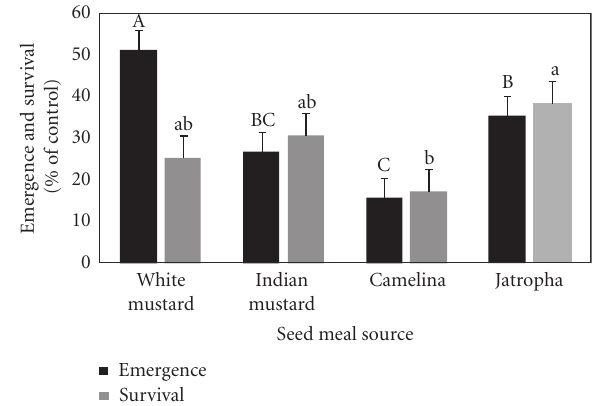
Figure 6: Main e ff ect of “seed meal source” on cotton emergence (uppercase letters) and survival (lowercase letters). Means within emergence or survival followed by the same letter are not di ff erent at P < 0 . 05 by Fisher’s protected LSD. Data are means (four replications) ±